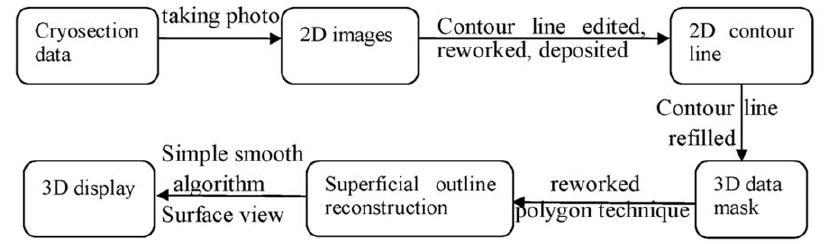
Figure 1. Flow chart of visualization of the LES and its related structures.